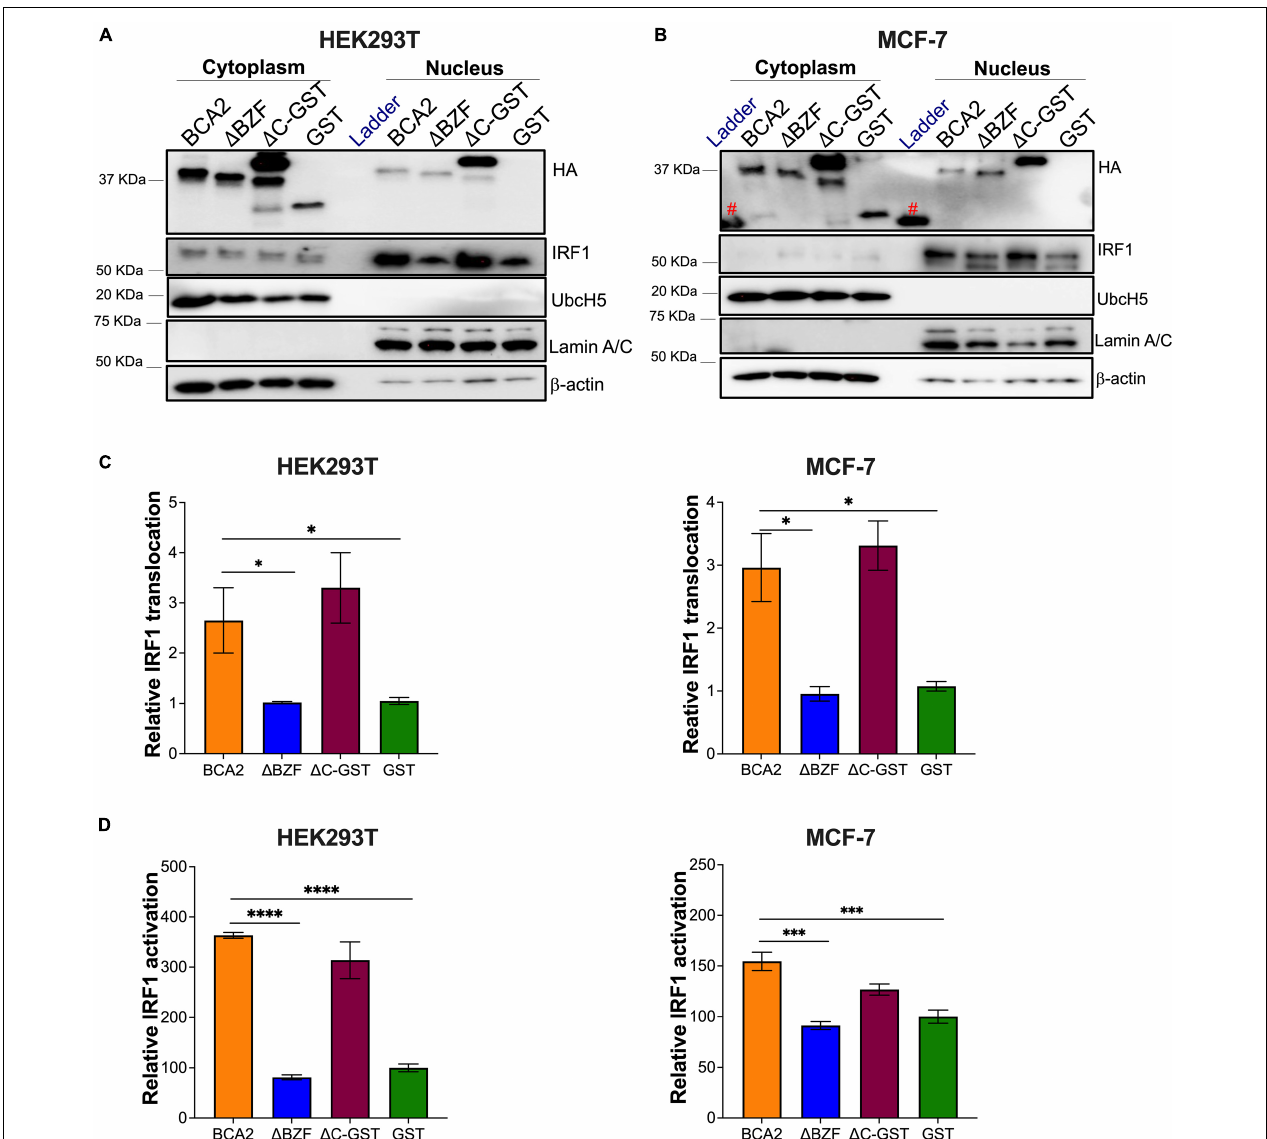
FIGURE 8 | BCA2 promotes the nuclear translocation and activation of IRF1 in HEK293T and MCF-7 cells. (A,B) Subcellular fractionation assays in HEK293T and MCF-7 cells were performed to determine the levels of cytosolic vs. nuclear IRF1 in the presence of HA-BCA2 and its truncation mutants. The blots are representative of 3 independent experiments. (C) The IRF1 nuclear translocation relative to GST was quantified by densitometry analyses by normalizing nuclear IRF1 to Lamin A/C. (D) Data was verified using IRF1 luciferase reporter assays. * p < 0.05, *** p < 0.001, **** p < 0.0001. Data correspond to the mean and SEM of 3 independent experiments. IP, immunoprecipitation; Red pound symbol, unspecific bands due to cross-reactivity of the antibody with the protein